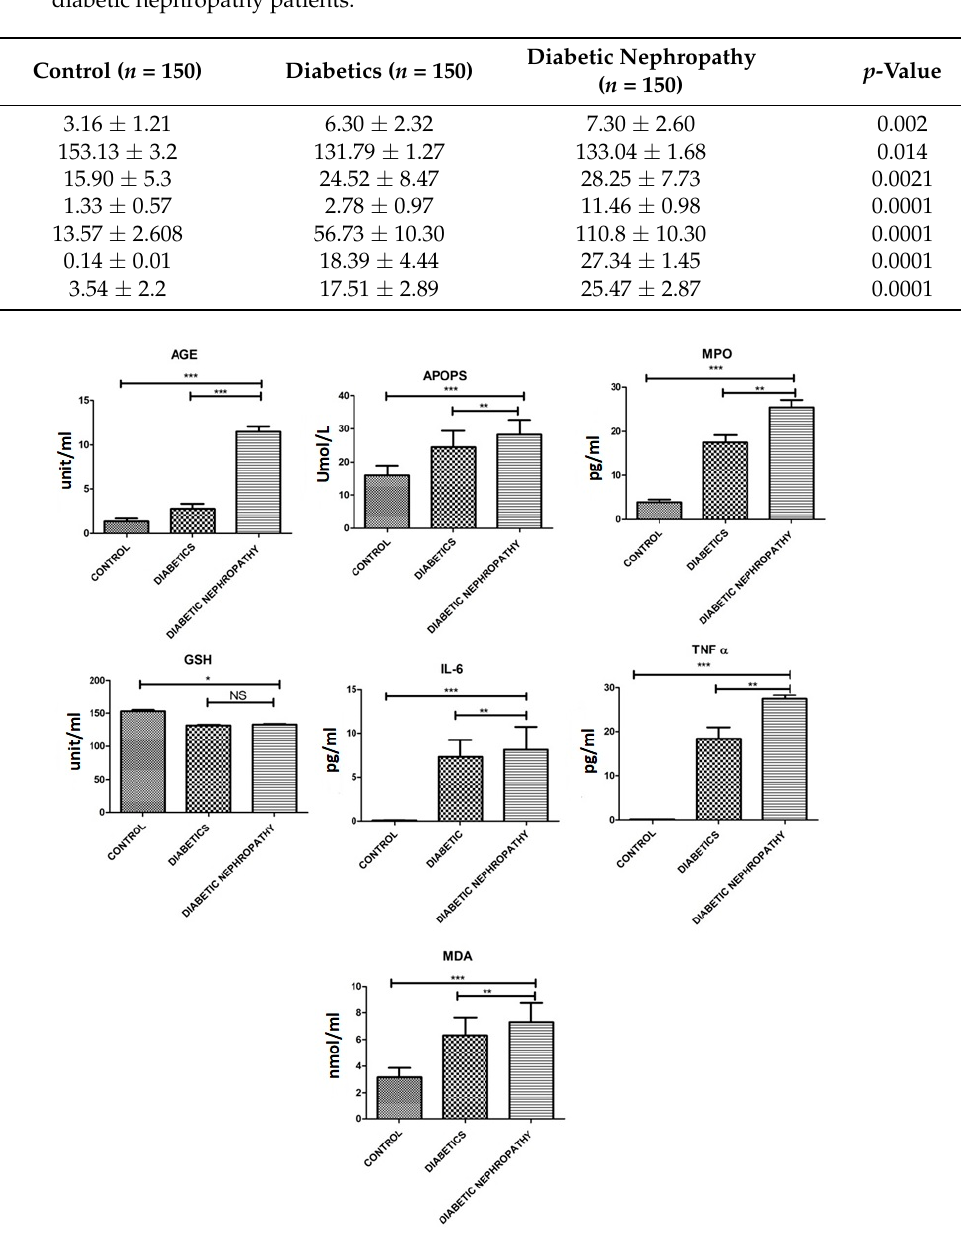
Figure 6. Levels of AOPPS, AGEs, TNFa, GSH, MPO, MDA and IL6 of all the individuals. There is a significant difference between control and diseased groups. Elevated levels of all the stress mark- ers and decreased levels of GSH can be observed in the diseased group compared to control while the stress markers are highly increased in the diabetic nephropathy group. Where p ≤ 0.05. *, **, *** (less, moderate, highly significant) represents the significant difference between groups.